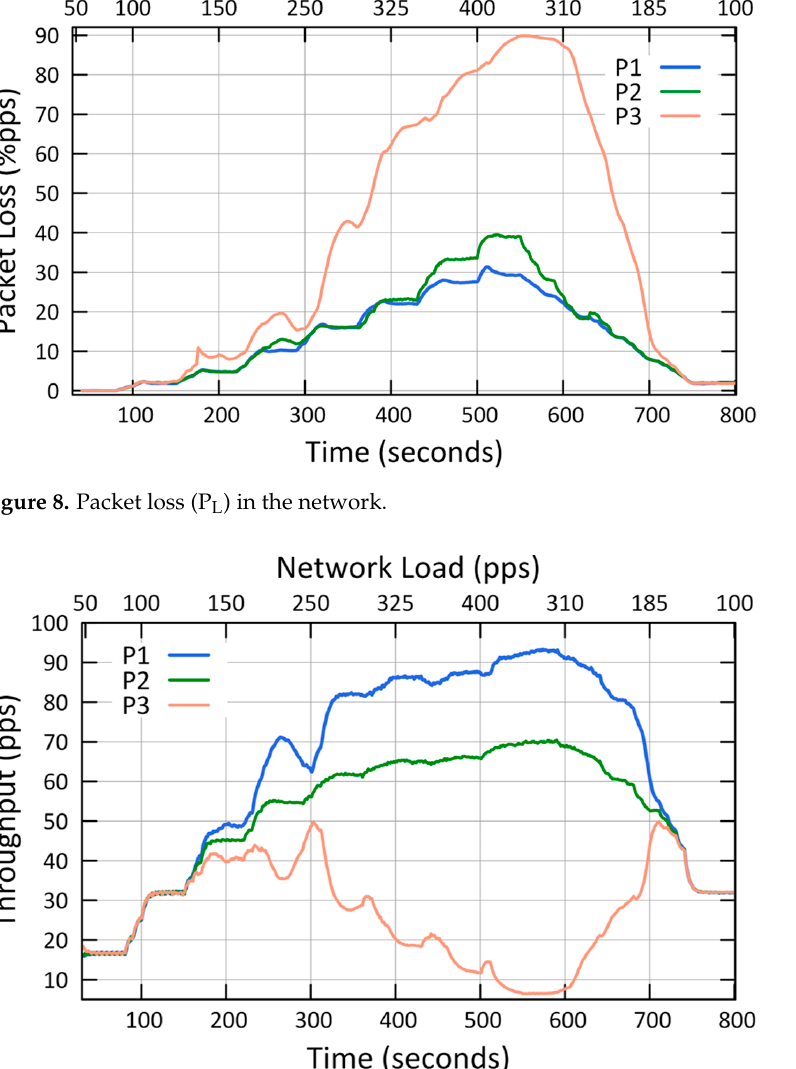
Figure 9. Throughput (T H ) in the Network.